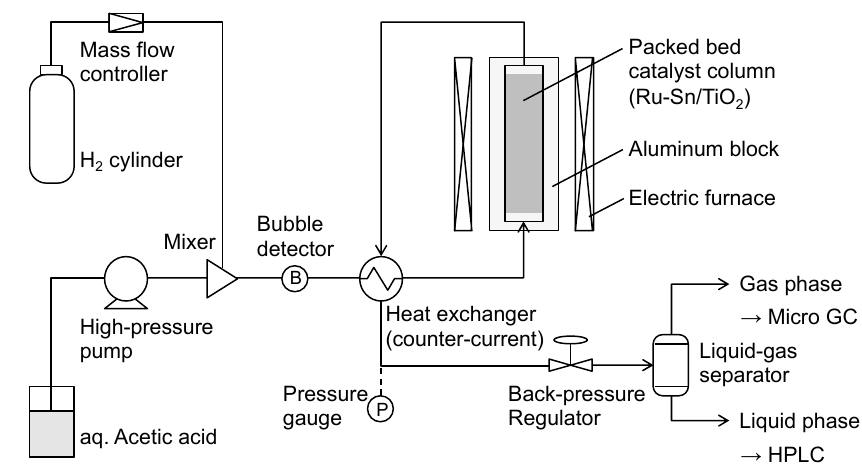
Figure 9. A flow-type reactor used for hydrogenation of aqueous acetic acid to ethanol.